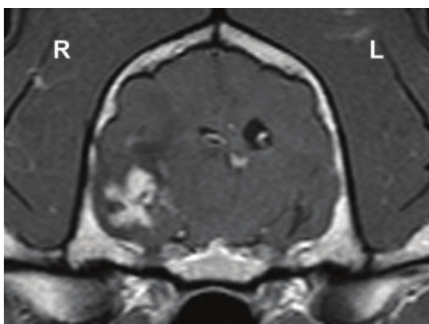
Figure 1: T1-weighted postcontrast transverse MR image of the brain at the level of the thalamus demonstrates a heterogeneous contrast-enhancing lesion in the right piriform lobe.